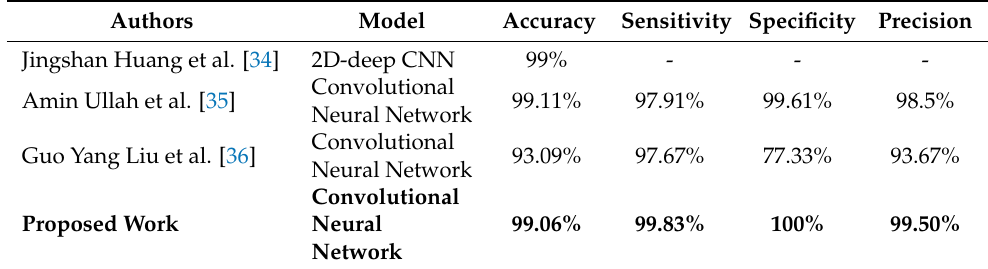
Table 3. Comparison with spectrogram